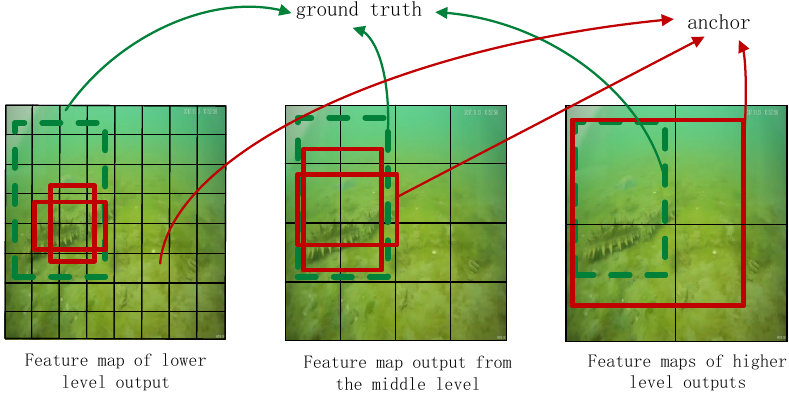
Figure 2. Output results from different levels of SSD.